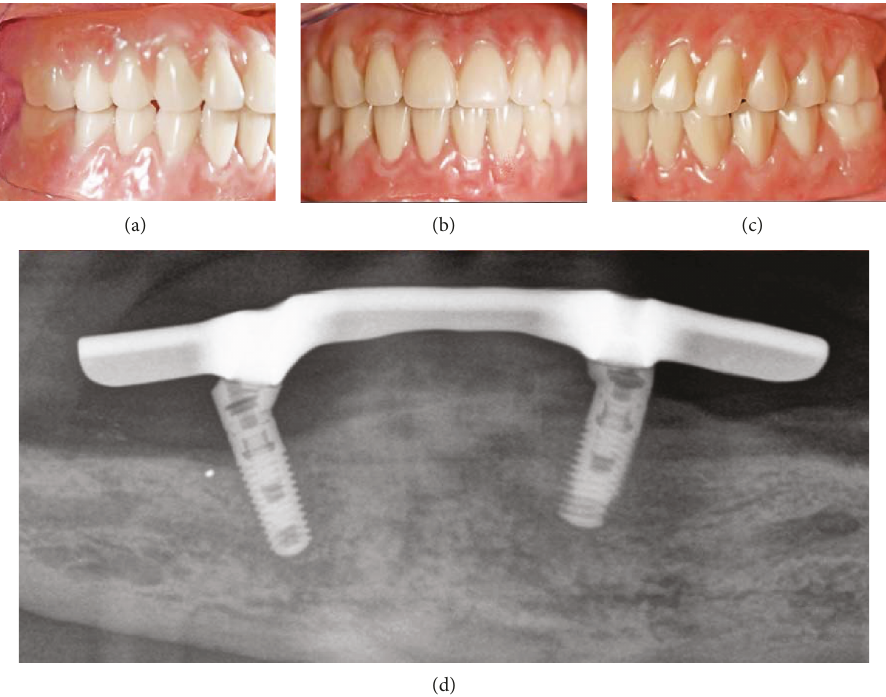
Figure 11: Final restorations in situ: (a) right; (b) front; (c) left; (d) OPG 3 years after